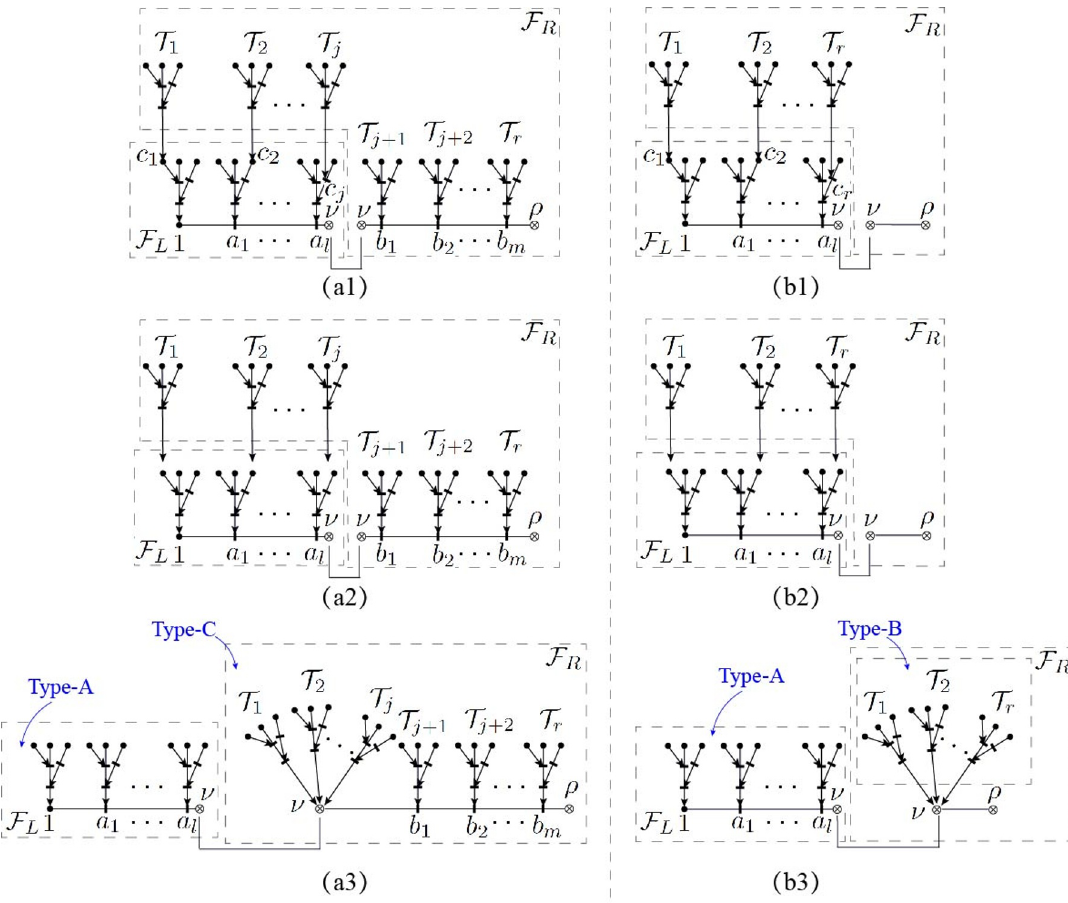
Figure 11 . If σ = { σ 1 , . . . , σ n − 1 } can be divided into σ L = { σ 1 , . . . , σ i − 1 } ∈ P (1 , i − 1) and σ R = { σ i , . . . , σ n − 1 } ∈ P ( i, n − 1) , a graph F ∈ G A [ σ ] is decomposed into F L and F R , as shown by (a1) and (b1). If a graph F is consistent with the permutation σ , a change of the roots of R R trees T which are planted at c must also result in a graph consistent with the permutation s s ∈ F L σ R . Thus all choices of c s must be included in the summation over F R , as shown by (a2) and (b2). Here, an arrow line pointing to a boxed region means that we sum over all possible graphs where the arrow line ends at a node in this regions. A type-A graph is finally factorized into a type-A graph and a type-C graph (see (a3)), or a type-A graph and a type-B graph (see (b3)).